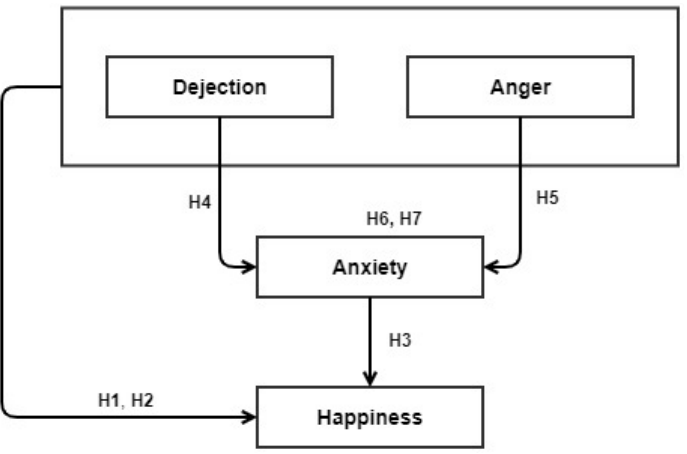
Figure 1. The hypothesized conceptual model.